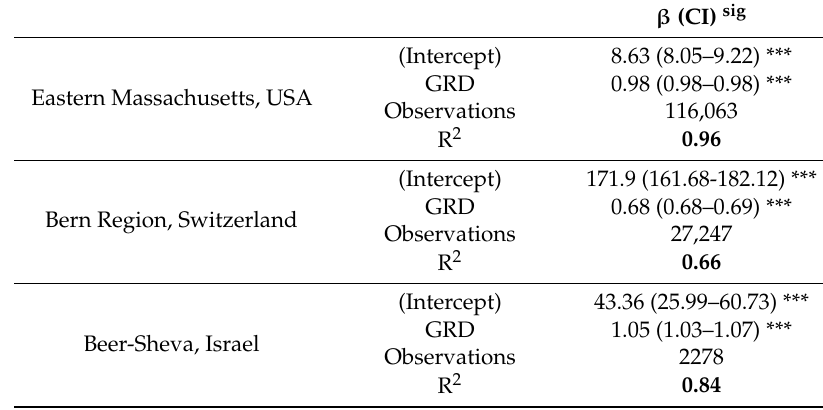
Table 7. Distance from the roads exposure assessment linear model results. β = Beta, CI =